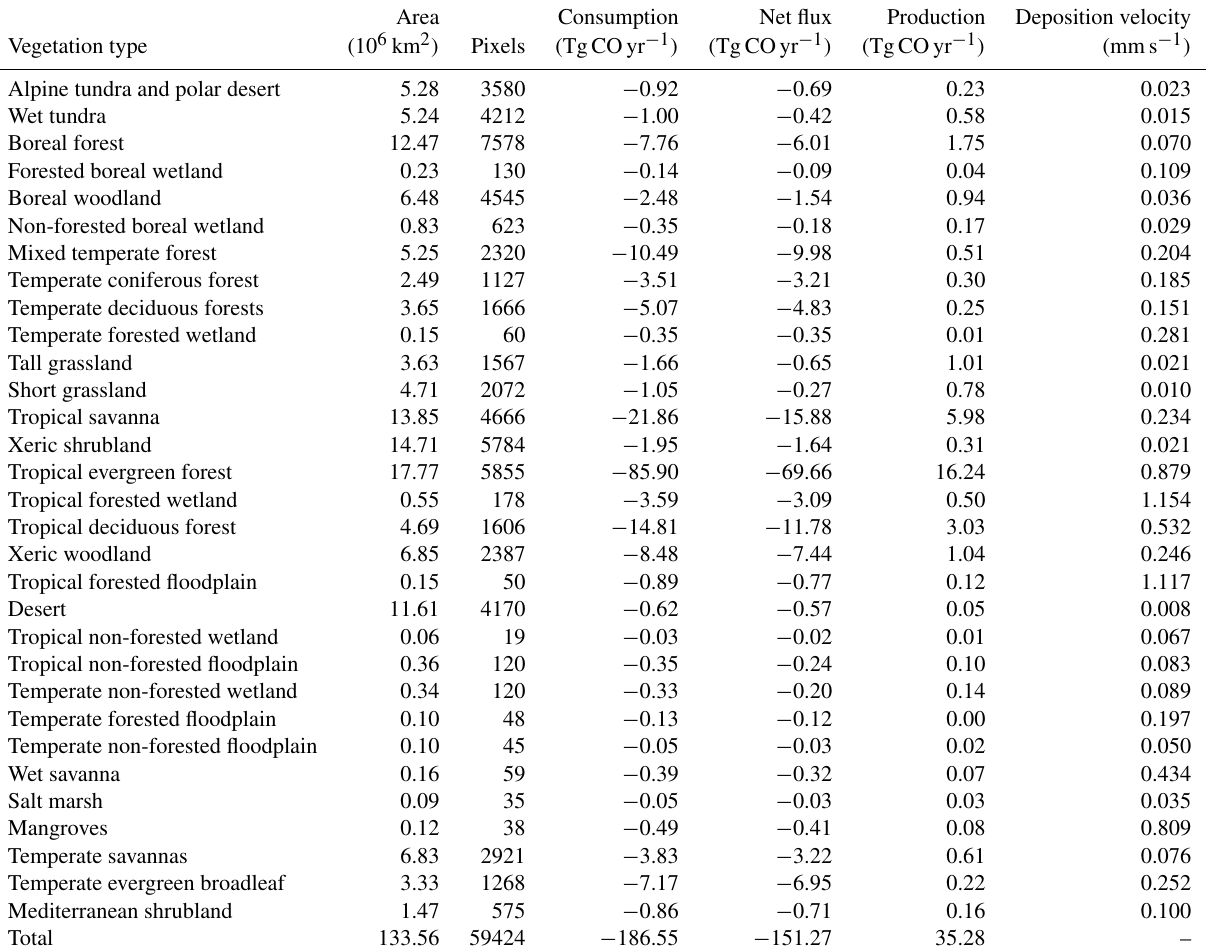
Table 4. Annual total soil CO consumption, net flux and production in different ecosystems during 2000–2013 (E1) and mean CO deposition velocity in different ecosystems during 1901–2013